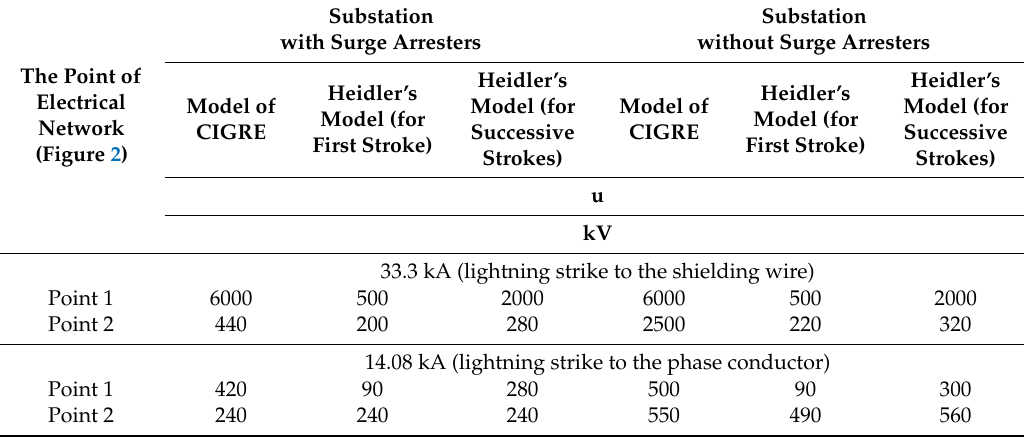
Table 2. Maximal values of overvoltages generated in selected points in the part of the electrical network with overhead transmission lines of 220 kV (Figure 2) determined on the basis of the results of simulation of transient voltage presented in Figures 5 and